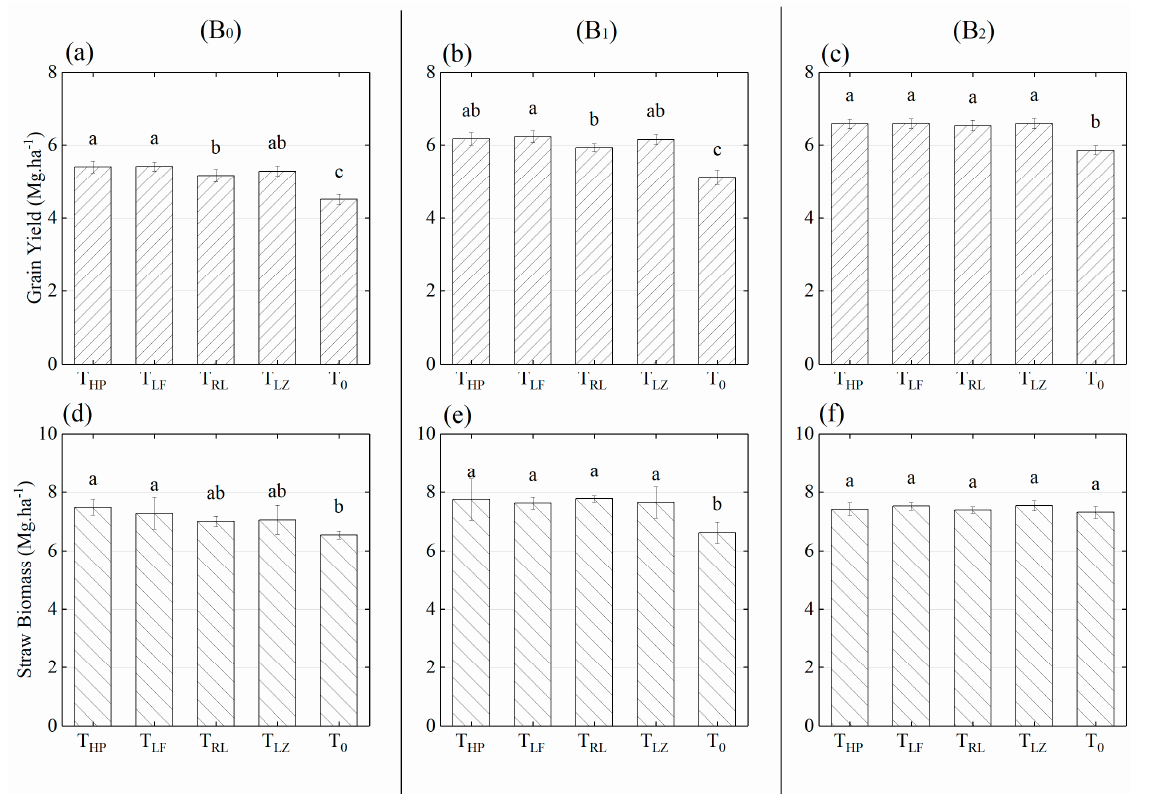
Figure 9. Grain yield and straw biomass of winter wheat under different topdressing methods. ( a – c ) Grain yields of different topdressing methods under three basal fertilizer levels. ( d – f ) Straw biomasses of different topdressing methods under three basal fertilizer levels. (B 0 , B 1 , and B 2 represent basal fertilizer levels of 0, 57 and 114 kg · N · ha − 1 , respectively; T HP , T LF , T RL , T PGY , and T LZ represent different topdressing methods; different letters indicate significance using Fischer’s protected least significant difference at p < 0.05).